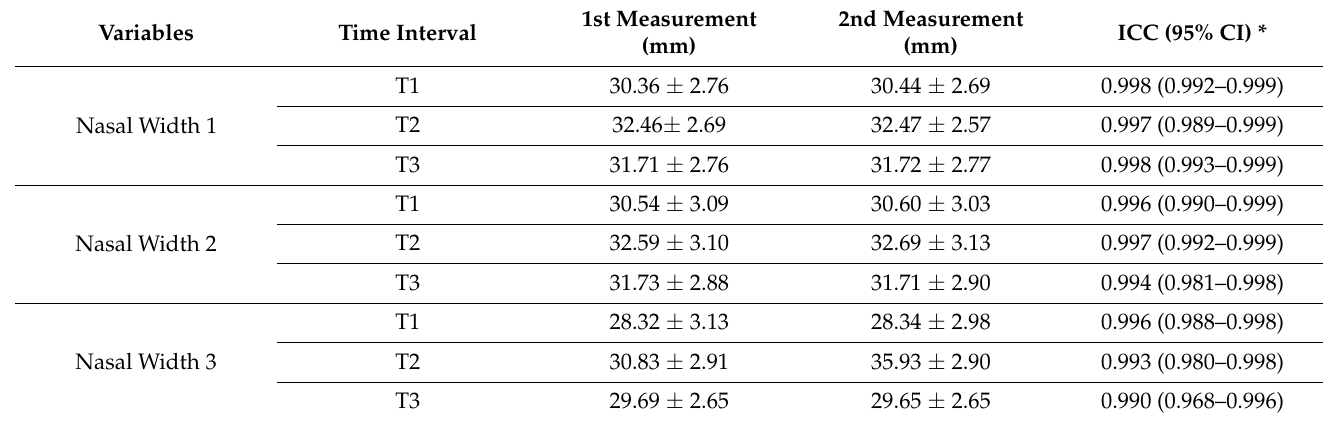
Table 1. Statistical indicators for the method of error for every parameter and time